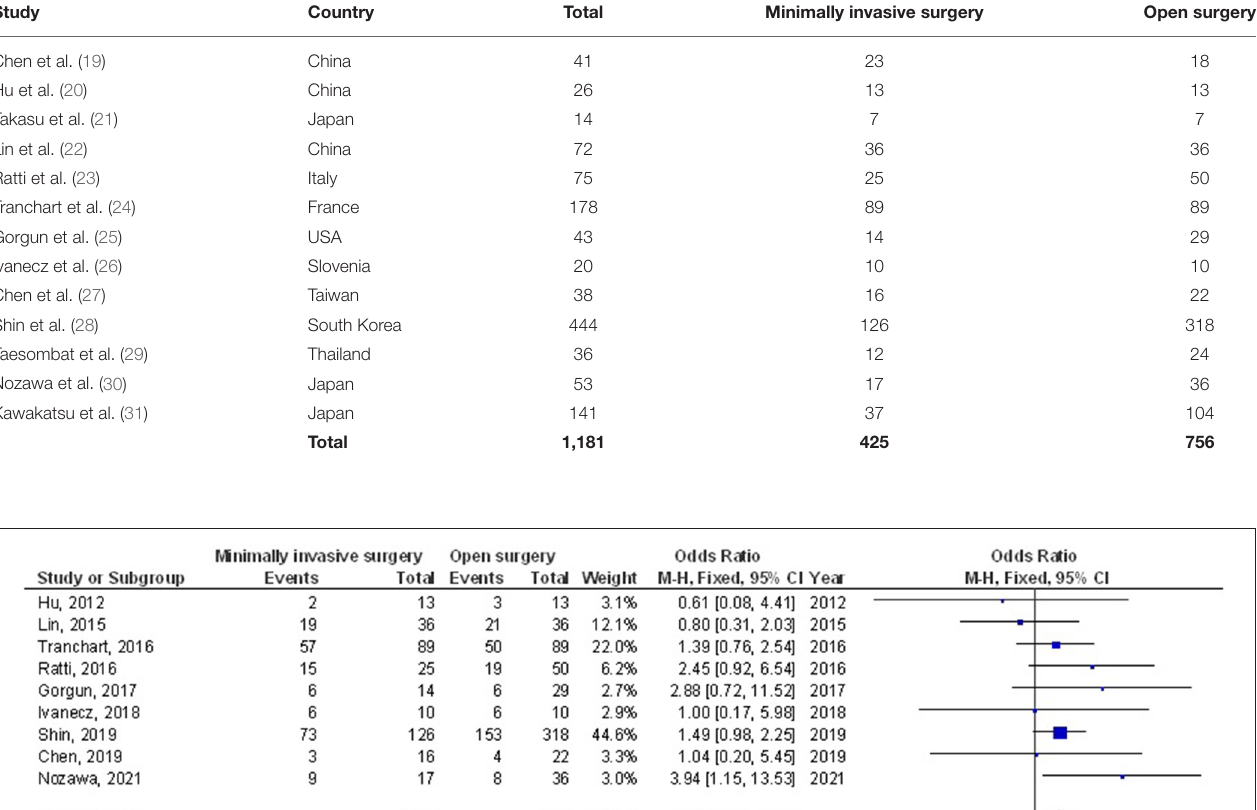
TABLE 2 | Characteristics of the selected studies for the meta-analysis.